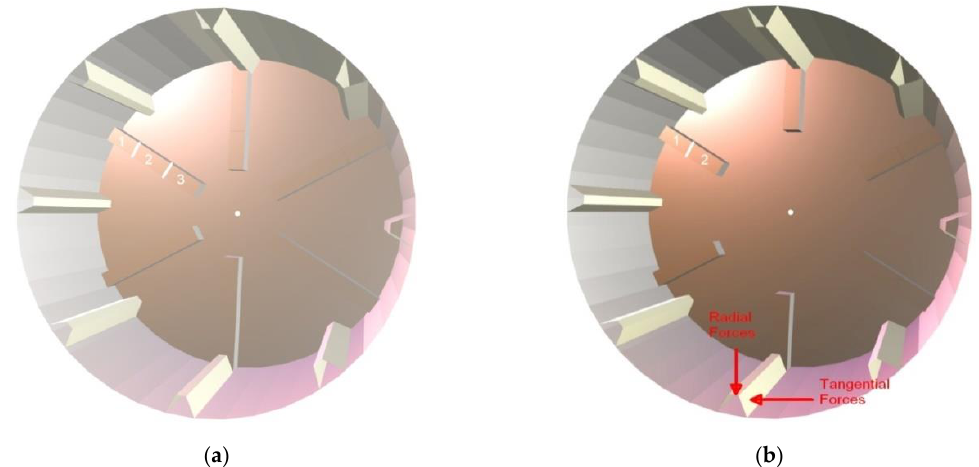
Figure 1. Shell and end lifter configuration used in the simulations. ( a ) Long end lifter and ( b ) short end lifter.